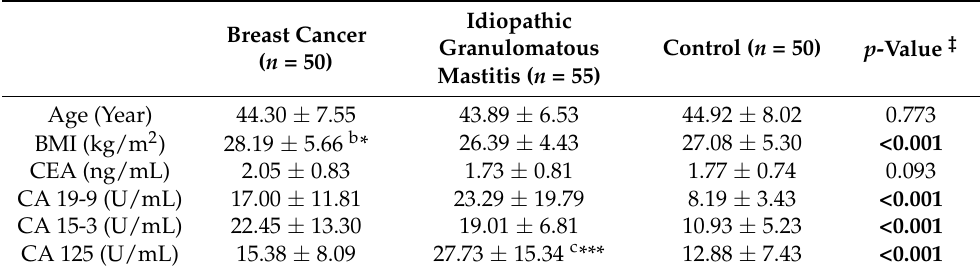
Table 1. Demographic characteristics and tumor markers of breast cancer, IGM and control groups a .